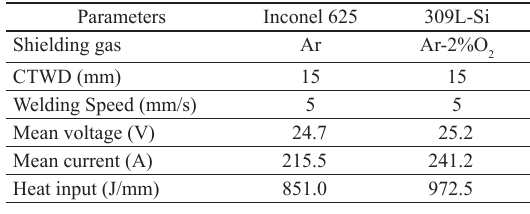
Table 2. Buttery and joint filling